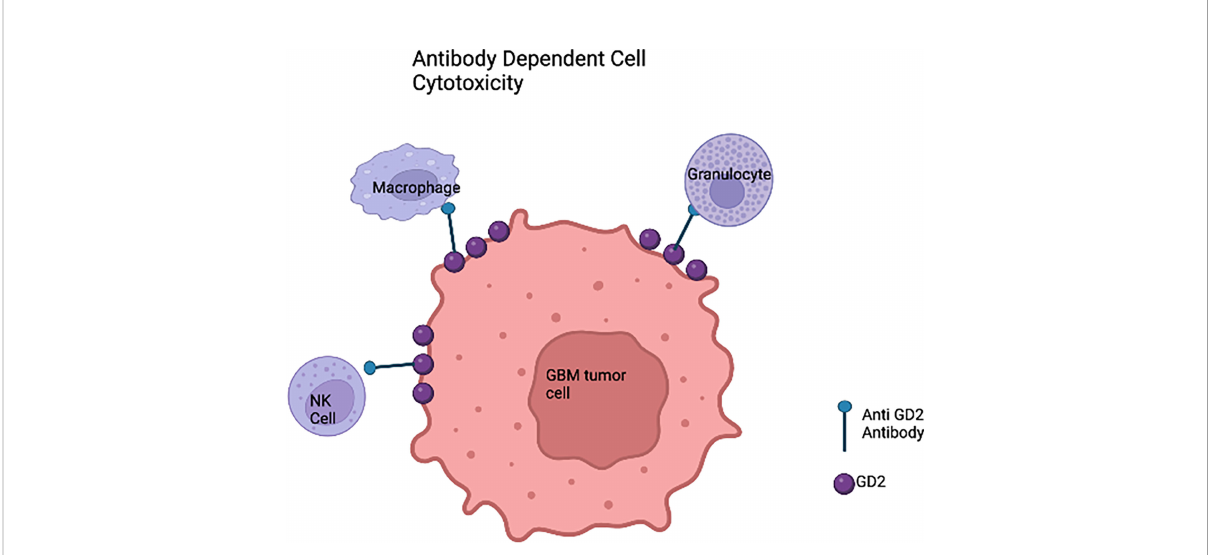
FIGURE 3 Anti-GD2 immunotherapy of glioblastoma cells based on the innate immune system. In the presence of anti-GD2 monoclonal antibodies,GBM cells would be susceptible to the activity of natural killer (NK) cells that would mediate antibody-dependent cell mediated cytotoxicity (ADCC), granulocyte mediated ADCC, and monocyte macrophage